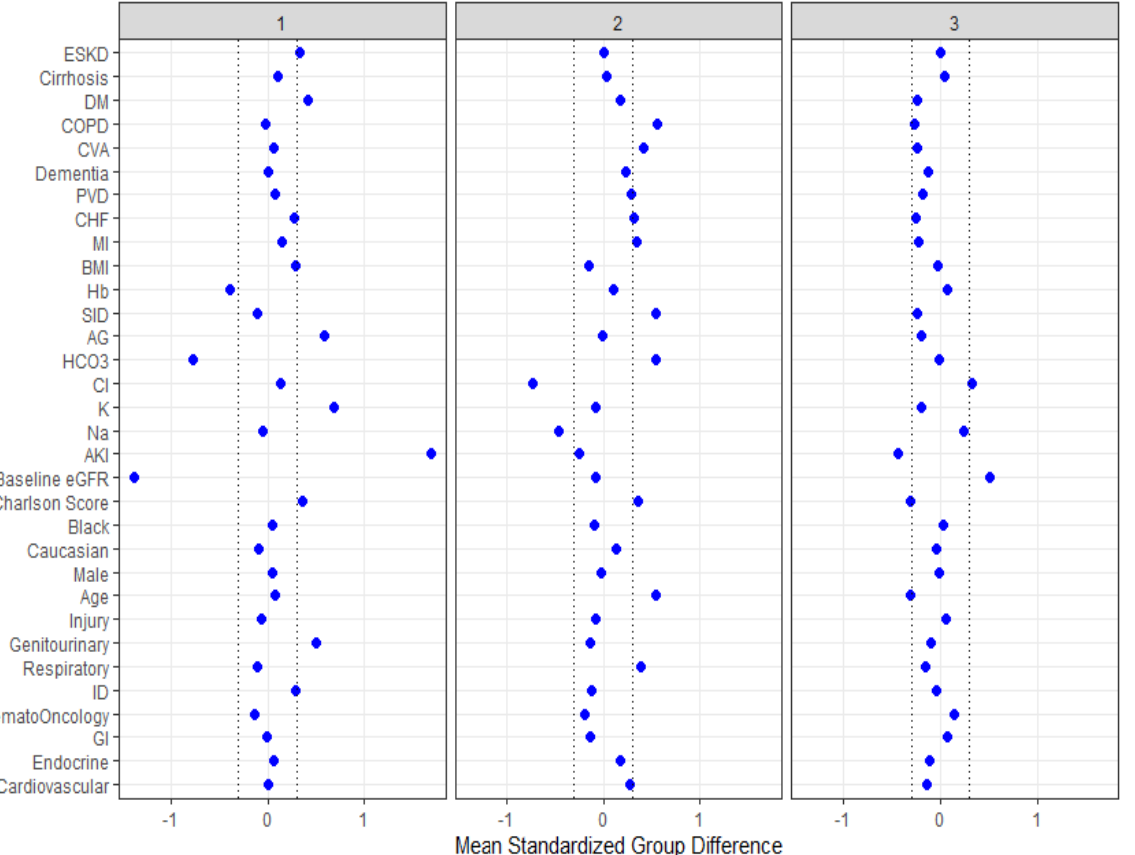
Figure 3. The standardized differences across three clusters for each of baseline parameters. The x axis is the standardized differences value, and the y axis shows baseline parameters. The dashed vertical lines represent the standardized differences cutoffs of < − 0.3 or >0.3. Abbreviations: AKI, acute kidney injury; DM, diabetes mellitus; COPD, chronic obstructive pulmonary disease; CVA, cerebrovascular accident; PVD, peripheral vascular disease; CHF, congestive heart failure; MI, myocardial infarction; BMI, body mass index; Hb, hemoglobin; SID, strong ion difference; AG, anion gap; ESKD, end stage kidney disease; HCO3, bicarbonate; Cl, chloride; K, potassium; Na, sodium; GFR, glomerular filtration rate; RS, respiratory system; ID, infectious disease; GI, gastrointestinal.